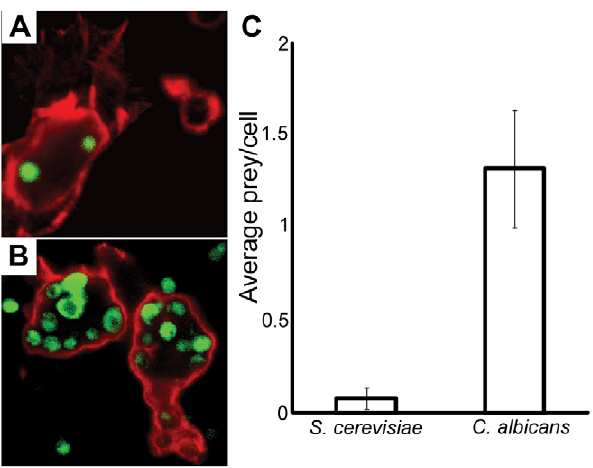
Figure 3. Drosophila mbn-2 cells phagocytose C.albicans more effectively than S. cerevisiae . Phagocytic prey, FITC- labeled S. cerevisiae (A) or C. albicans (B) are shown in green and F-actin in mbn-2 cells is shown in red. C. The average number of internalized fungal cells per mbn-2 cell (n . 400) from three independent experiments was quantified.